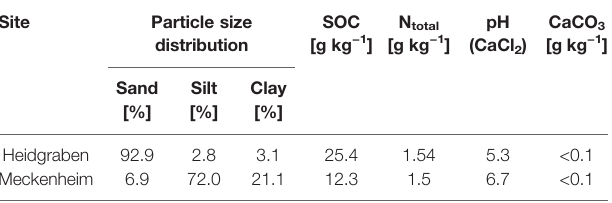
TABLE 1 | Major properties of soils from the two apple replant disease (ARD) sites Heidgraben and Meckenheim at 0 – 20 cm depth.